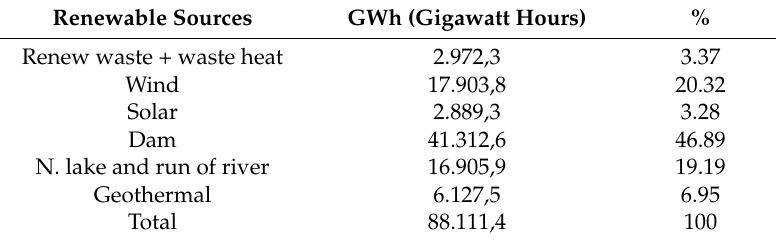
Figure 1. Distribution of renewable energy resources in Turkey (2017) [19]. Table 2. Energy production by renewable sources in Turkey (2017) [19].